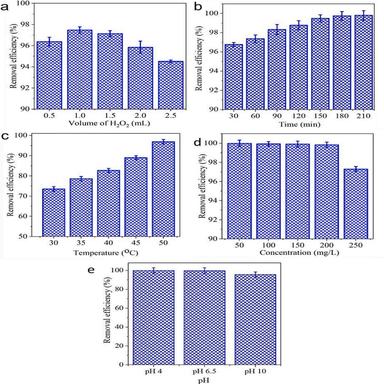
Effects of (a) the volume of H2O2 (20 mL of 200 mg/L MB, 60 min, 50 ◦C, and 0.01 g FG2I), (b) time (20 mL of 200 mg/L MB, 1 mL H2O2 30%, 50 ◦C, and 0.01 g FG2I), (c) temperature (20 mL of 200 mg/L MB, 1 mL H2O2 30%, 180 min, 0.01 g FG2I), (d) concentration (1 mL H2O2 30%, 180 min, 50 ◦C, 0.01 g FG2I), and (e) pH of MB (20 mL of 200 mg/L MB, 1 mL H2O2 30%, 180 min, 50 ◦C, and 0.01 g FG2I) on Fenton catalytic efficiency of FG2I material.